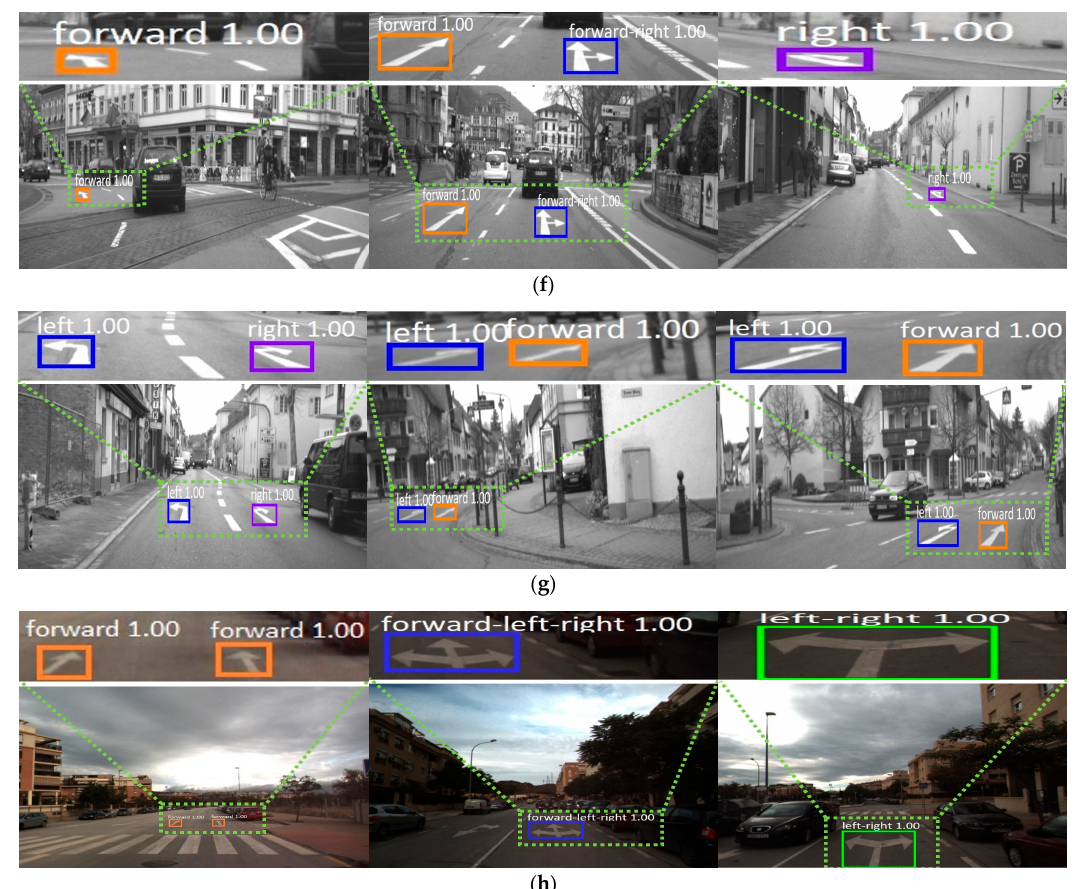
Figure 11. Examples of correct detection and classification cases. ( a ) Seq01TP, ( b ) Seq05VD, ( c ) Seq06R0, and ( d ) Seq16E5 from the Cambridge dataset; ( e ) Test2, ( f ) Train1, and ( g ) Train3 from the Daimler dataset; ( h ) Malaga urban dataset. In ( a – h ), true positive cases are shown by the boxes of various colors.